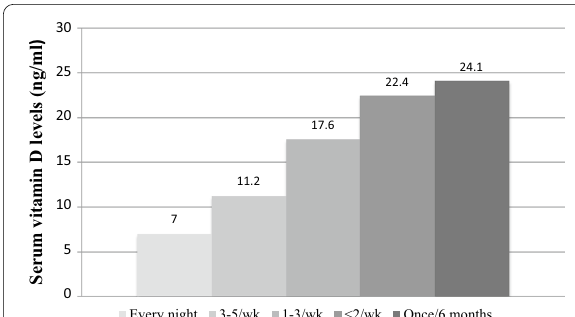
Fig. 2 The frequency of bed‑wetting according to 25(OH) D concentrations. The lower mean 25(OH) D concentrations were associated with higher frequencies of bed wetting (Every night: 7.0 1.4, 3–5 time/week: 11.2 1.7, 1–3 times/week: 17.6, < 2times/ ± ± week: 22.4 2.9, Once/6 month: 24.1 4.3 (ng/ml), P < ± ±